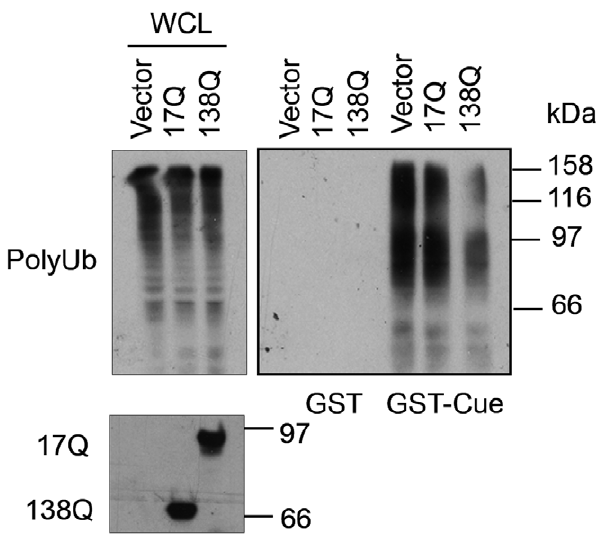
Figure 6. Effects of Nhtt17Q and Nhtt138Q on polyubiquiti- nated protein binding to the cue domain of gp78. Nhtt138Q inhibits polyubiquitin binding to gp78 more than Nhtt17Q. Lysates prepared from HEK293 cells expressing equal amount of Nhtt138Q and Nhtt17Q were used in GST-cue pull down assay. Association of polyubiquitinated proteins with GST or GST-cue was determined by anti-ubiquitin blotting.